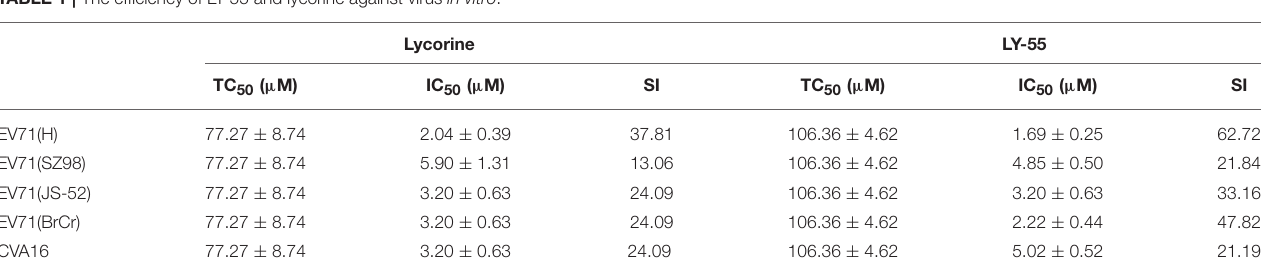
TABLE 1 | The efficiency of LY-55 and lycorine against virus in vitro